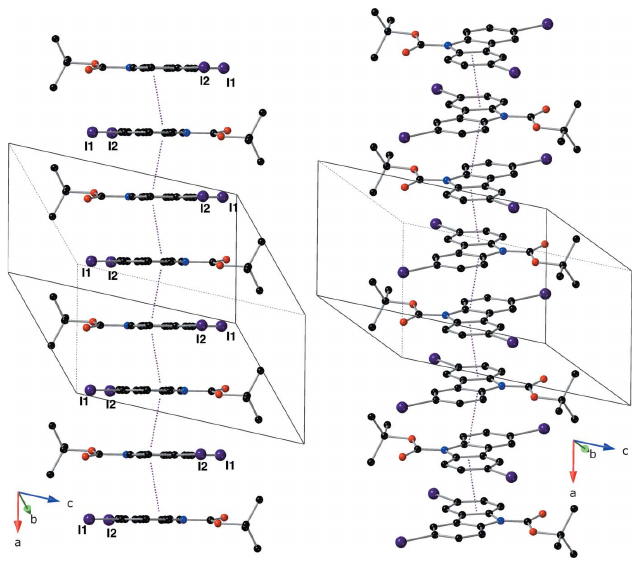
Figure 2 A depiction of the supramolecular pillars using a ball-and-stick model with standard CPK colors (I = purple). The left portion of the figure shows the pillars with a view that is aligned with the plane of the aromatic carbazole system, the right portion of the figure shows the same molecules tilted slightly along the b axis. The (cid:2) – (cid:2) interactions described in the text are depicted with purple dotted lines and the unit cell is drawn with a solid black line.